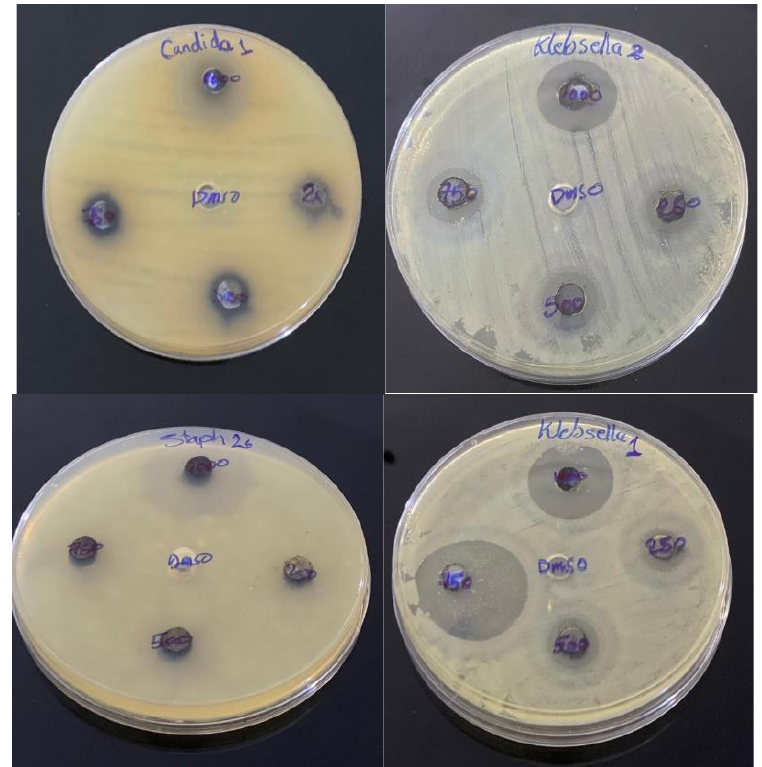
Figure 5(b): The bacterial activity (Agar Well Diffusion Method) for Fe